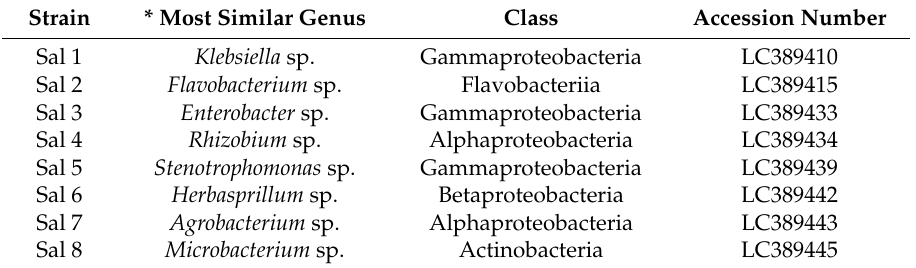
Table 1. Endophytes used in this study isolated from sweet potato cultivated in Salyan, Nepal. Strain * Most Similar Genus Class Accession Number Sal 1 Klebsiella sp. Gammaproteobacteria LC389410 Sal 2 Flavobacterium sp. Flavobacteriia LC389415 Sal 3 Enterobacter sp. Gammaproteobacteria LC389433 Sal 4 Rhizobium sp. Alphaproteobacteria LC389434 Sal 5 Stenotrophomonas sp. Gammaproteobacteria LC389439 Sal 6 Herbasprillum sp. Betaproteobacteria LC389442 Sal 7 Agrobacterium sp. Alphaproteobacteria LC389443 Sal 8 Microbacterium sp. Actinobacteria